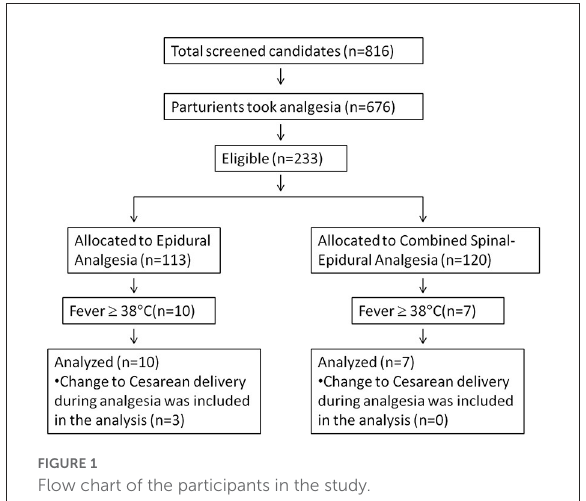
FIGURE1 Flow chart of the participants in the study.